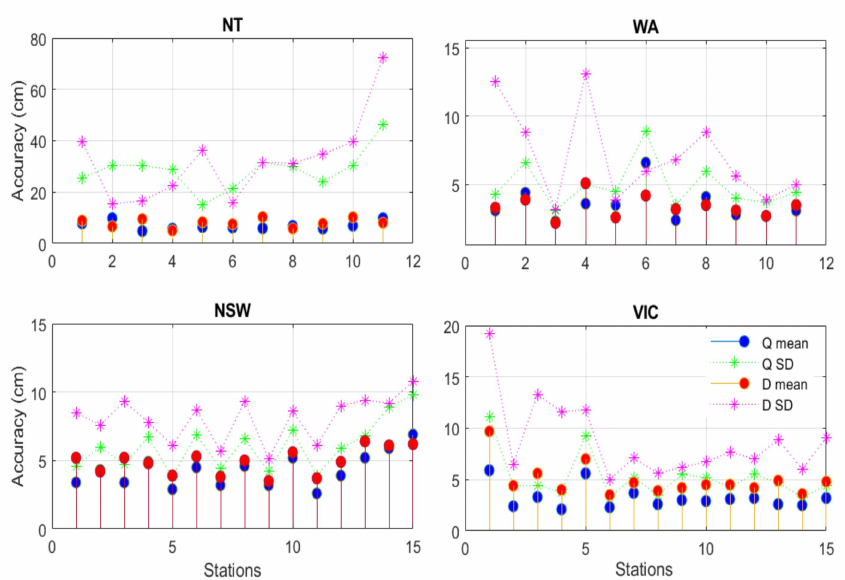
Figure 13. Comparison of average accuracy in quiet day (Q on 6 May 2021) and disturbance day (D on 12 May 2021). The blue and red markers show the mean accuracy of the testing stations, whereas the green and pink stars present the standard deviation of the accuracy on the quiet and disturbance day,